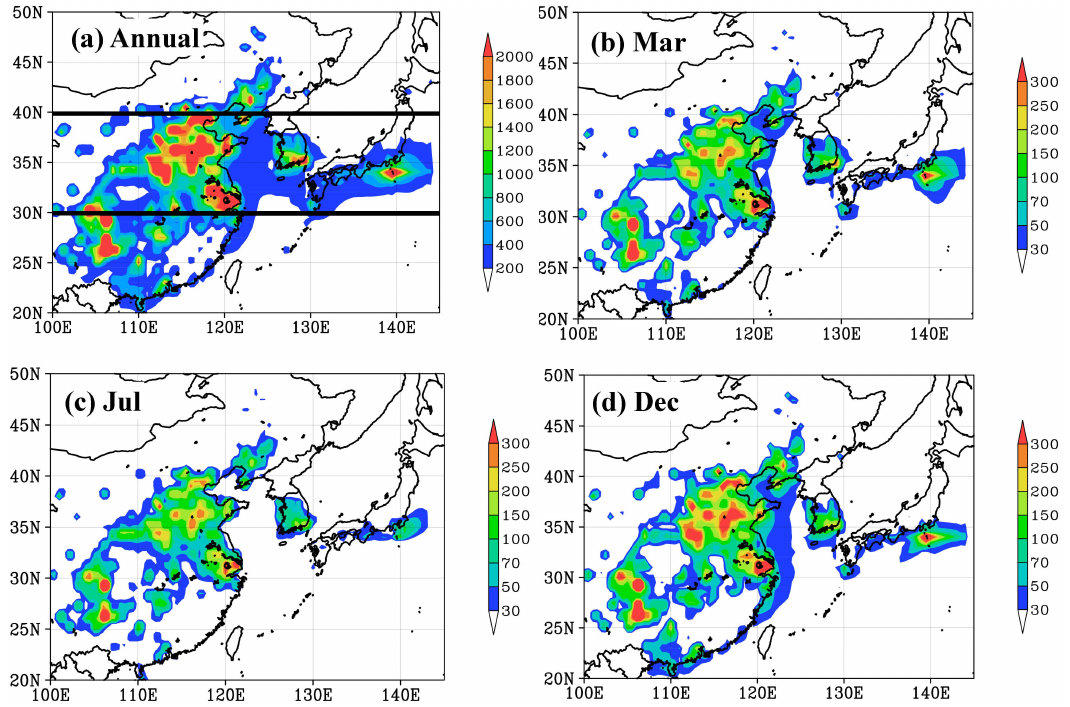
Fig. 3. Spatial distributions of (a) annual and (b–d) monthly accumulated dry deposition of total S (mgSm − 2 ). The solid lines in (a) indicate 40 ◦ N and 30 ◦ N, the borders between Regions I and II and between Regions II and III,